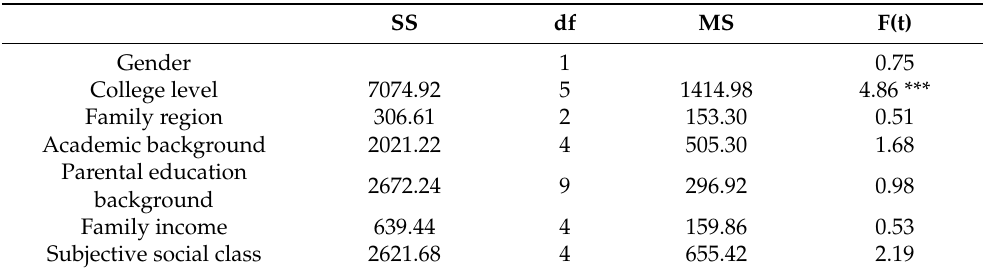
Table 6. Difference test of involution involvement in various demographic variables.